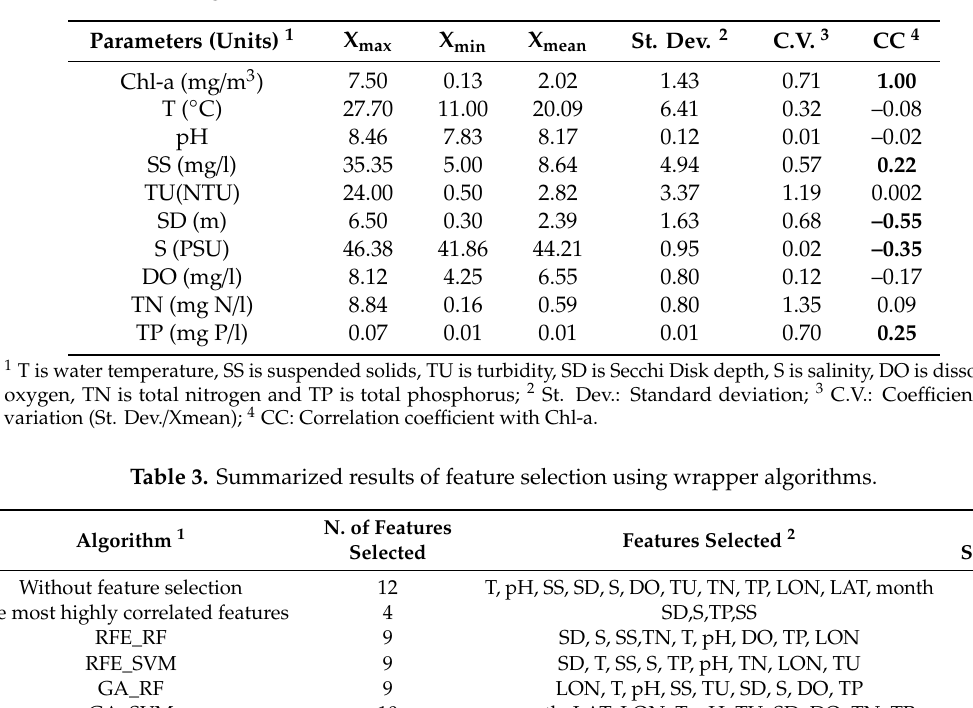
Table 2. Daily statistics of the water quality parameters between September 2017 and December 2018 in the Mar Menor Lagoon.